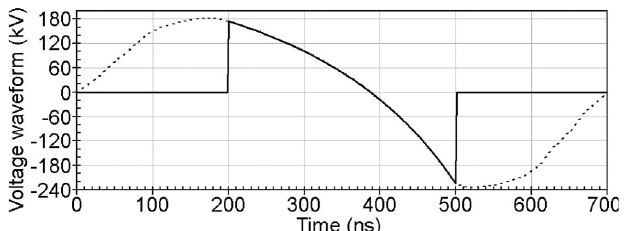
FIG. 2. (Color) Compression ratio I laboratory frame at multiple axial locations near the focal plane ( z (cid:4) (cid:8) 59 : 5 cm ), in steps of (cid:1) z (cid:4) 0 : 1 cm . The beam is initial- ized with T k (cid:4) 0 eV and encounters the sharp waveform across a 3 cm long gap. The results for the infinitely thin gap case (including the spatial and temporal offsets) are provided for comparison (constant current